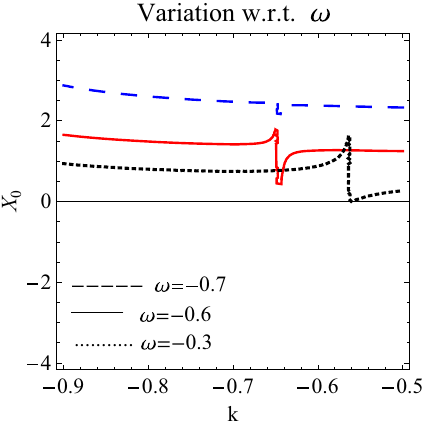
Fig. 5 Show the variation of Slope X 0 of outgoing radial null geodesic at r = 0 in Penrose diagram as a function of the equation of state parameter k for different values of the Brans–Dicke parameter ω in Brans–Dicke gravity’s rainbow. In figure, the other parameters are fixed at α = 0 . 1 ,β = 5, γ = 1, V 0 = 0 . 1, η = 1, E 1 = 1 . 42 × 10 − 13 , E p = 1 . 221 × 10 19